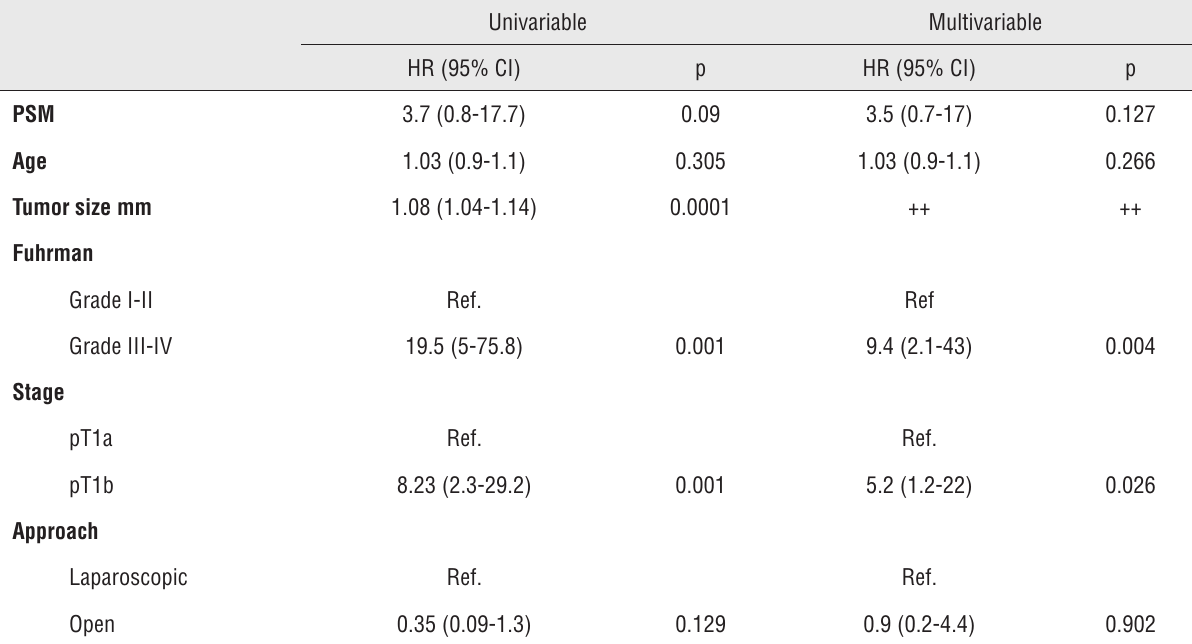
Table 3 - Univariable and multivariable analysis of distant